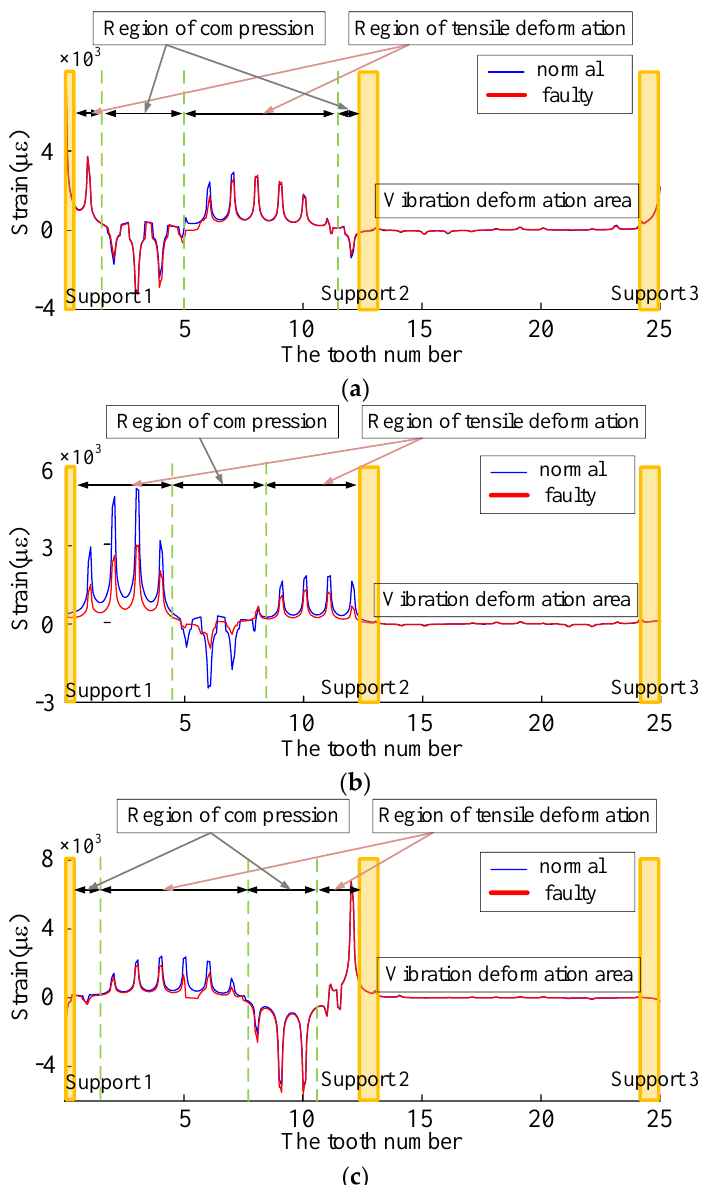
Figure 22. ( a ) State 2 strain wave curve. ( b ) State 3 strain wave curve. ( c ) State 4 strain wave curve.